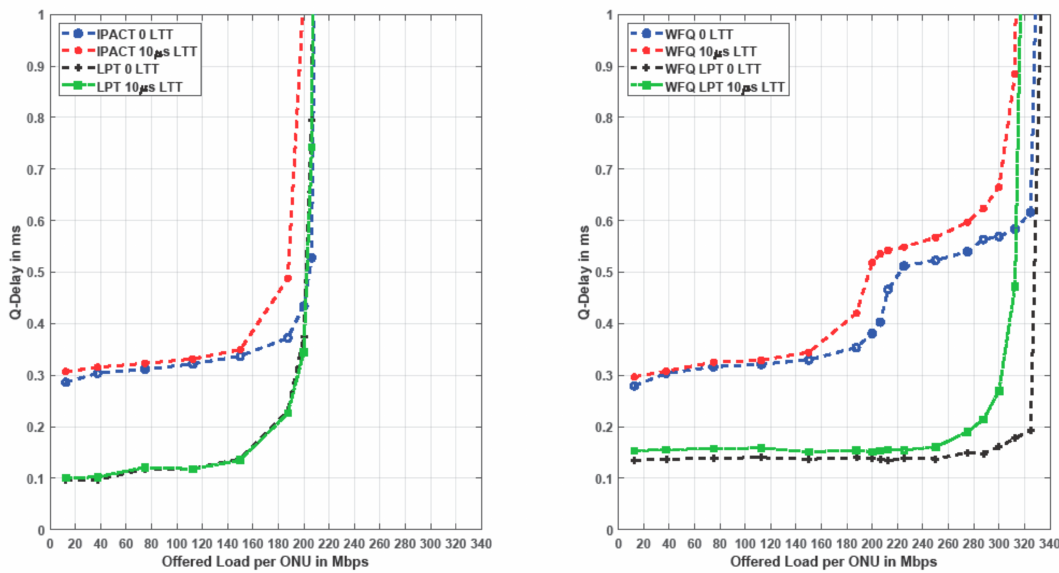
Figure 8. Queue delay for ONU 1 at both LTT = 0 µ s and LTT = 10 µ s; IPACT and LPT ( left ); and WFQ and WFQLPT ( right ).